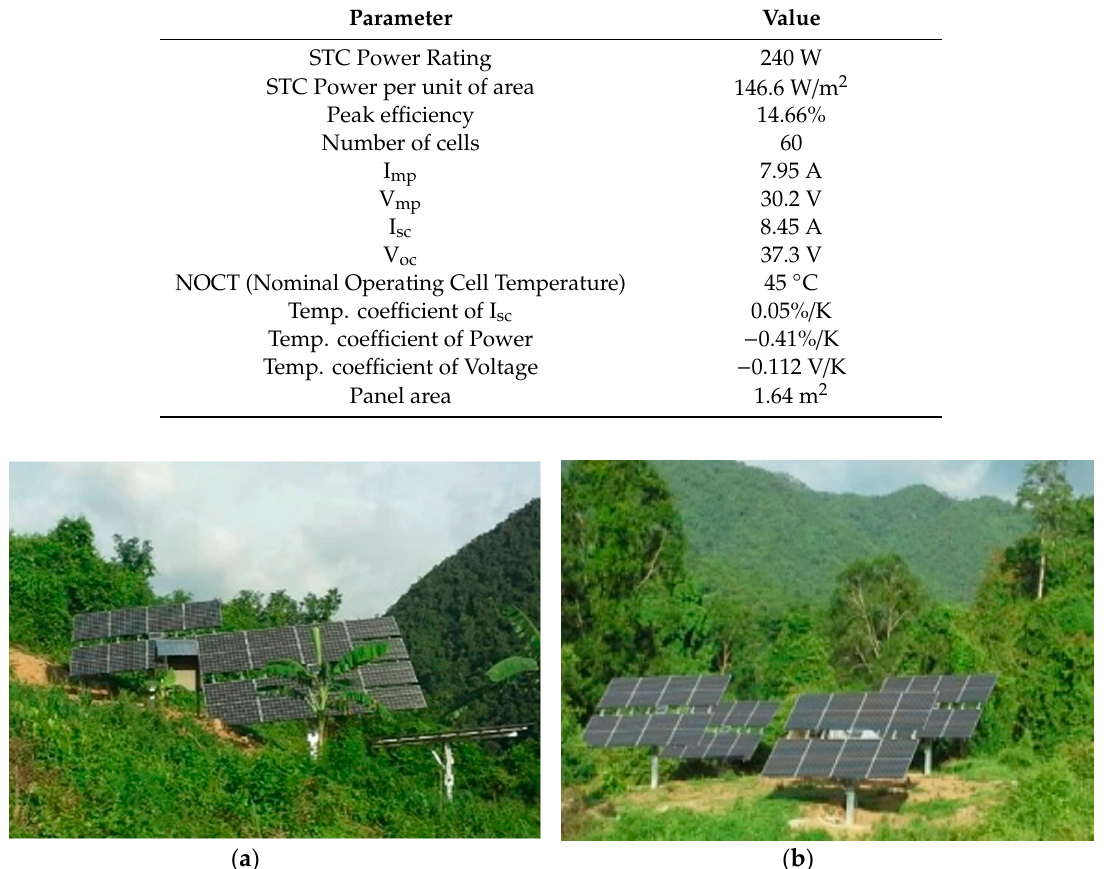
Figure 6. Solar photovoltaic (PV) panels integrated with the solar trackers installed at two site locations: ( a ) Location 1: Pongluek village; ( b ) Location 2: Bangkloy village.